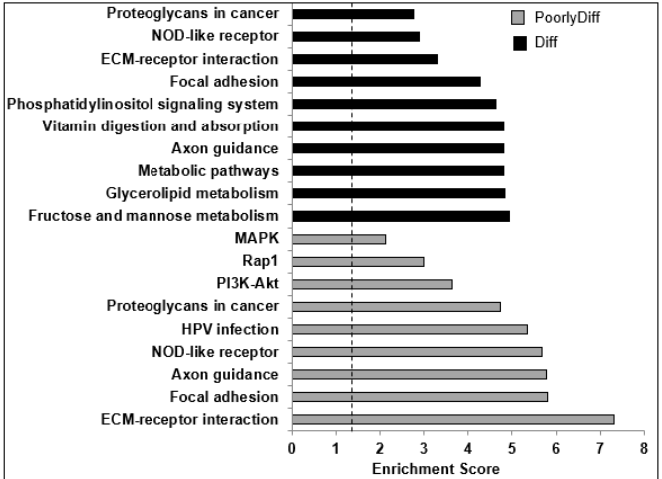
Figure 4. Graph of significantly enriched KEGG pathways (p-EASE ≤ 0.05) of upregulated genes (UP subset = Log 2 FC > 0.5, FDR < 0.1) in both poorly and moderately differentiated PDAC patient samples when compared to normal pancreatic tissue. Above the dotted line represents statistical significance at p value < 0.05, as calculated by Fisher’s exact test.